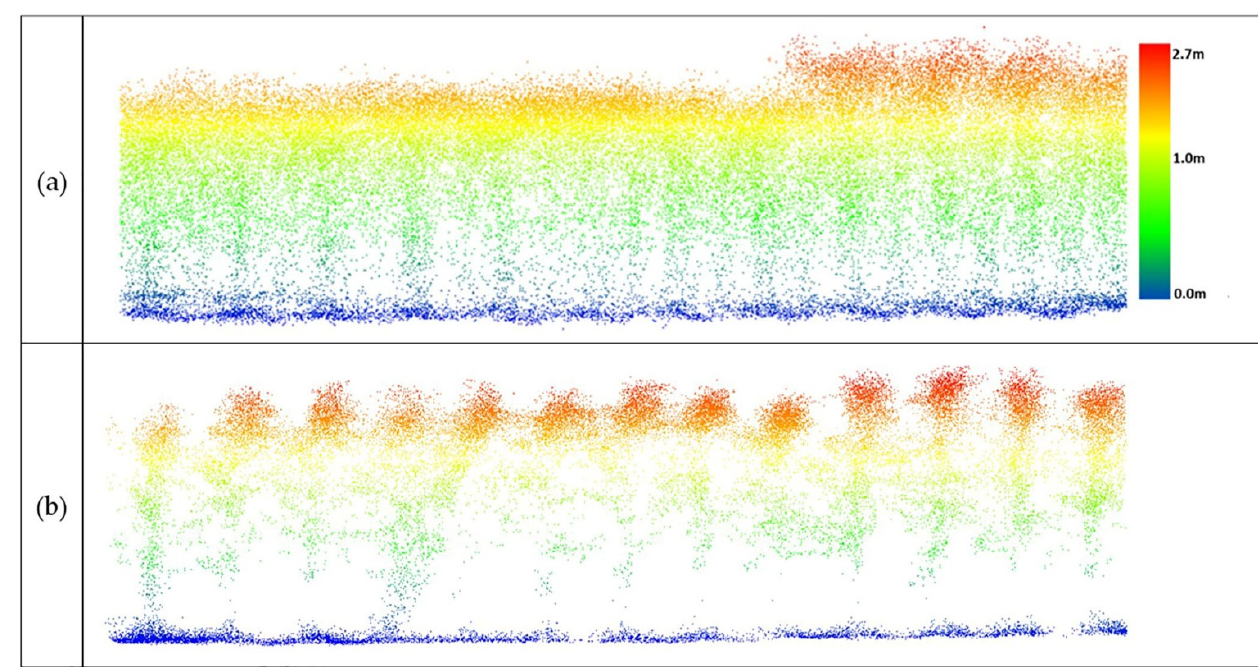
Figure 18. Data from UAV-1 at 20 m altitude over maize (DAS: 60). ( a ) Original data, ( b ) outlier removal with PointCleanNet.